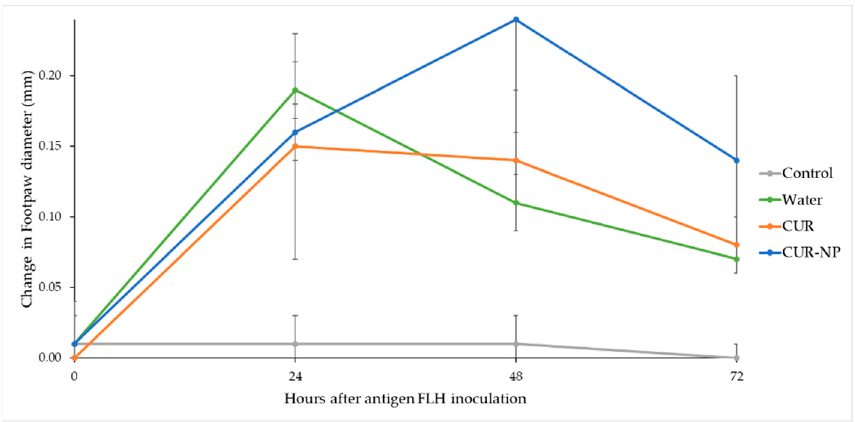
Figure 7. Delayed-type hypersensitivity (DTH) test expressed as change in footpad thickness for each treatment measured at 0, 24, 48 and 72 h. treatment measured at 0, 24, 48 and 72